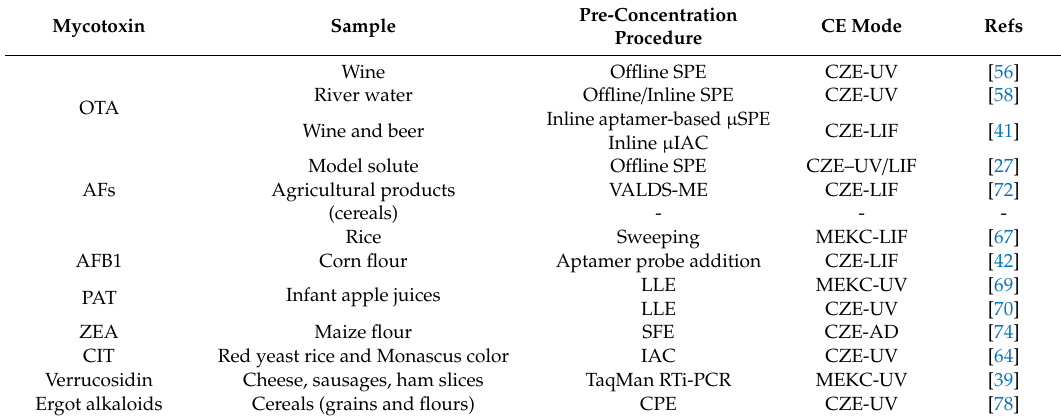
Table 1. Types of mycotoxins, relative sample preparations and CE